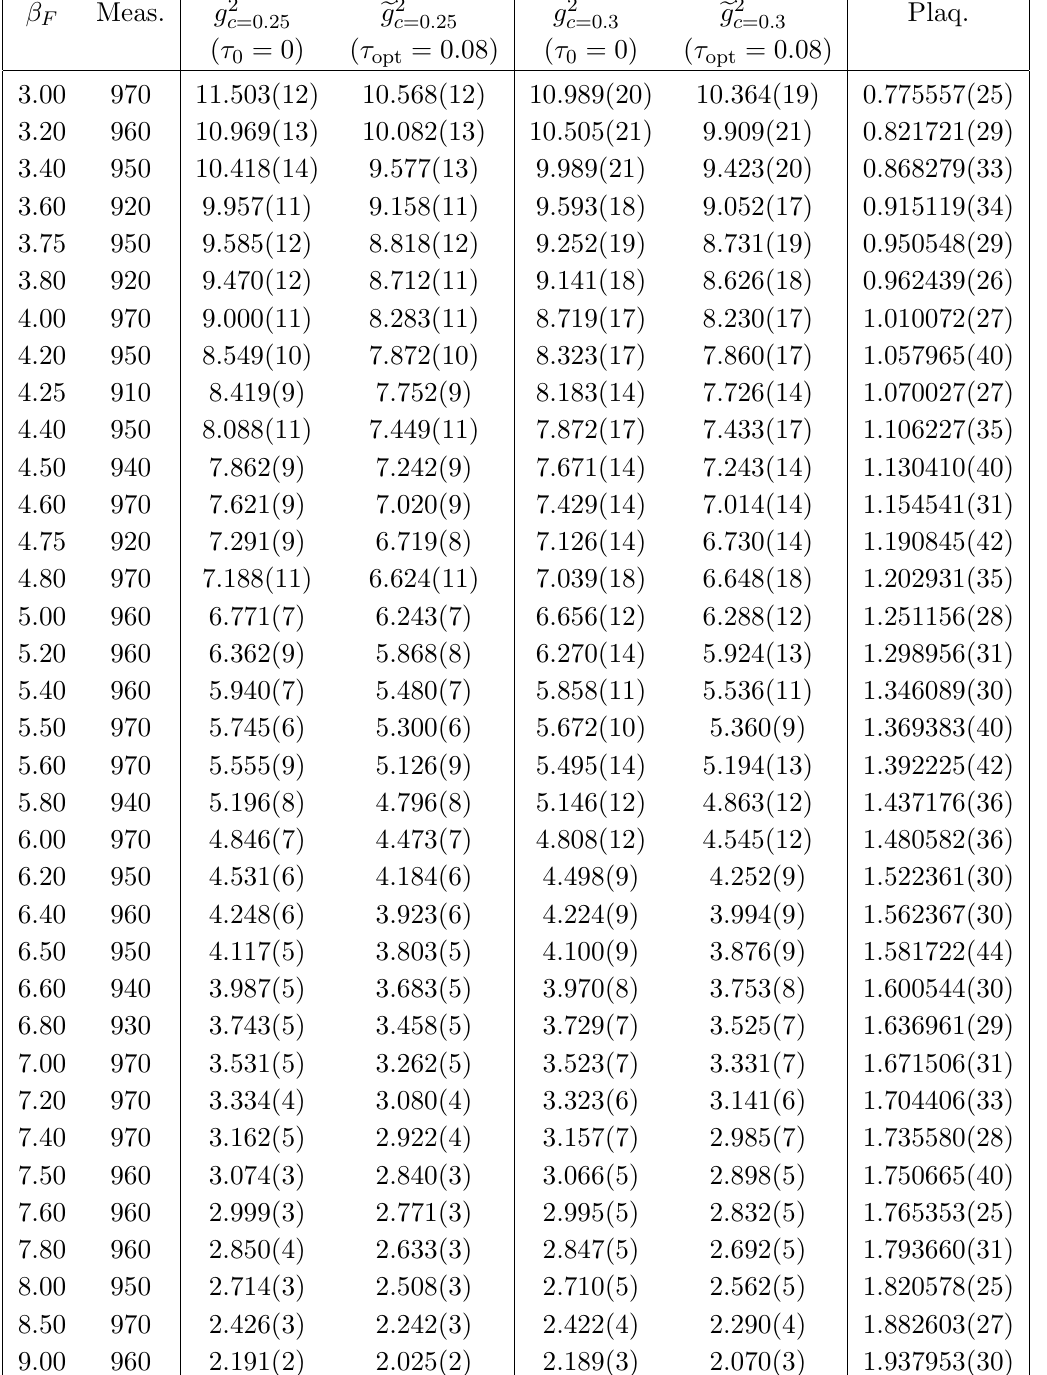
Table 4 . 16 4 lattice ensembles used in this work, with columns as in table